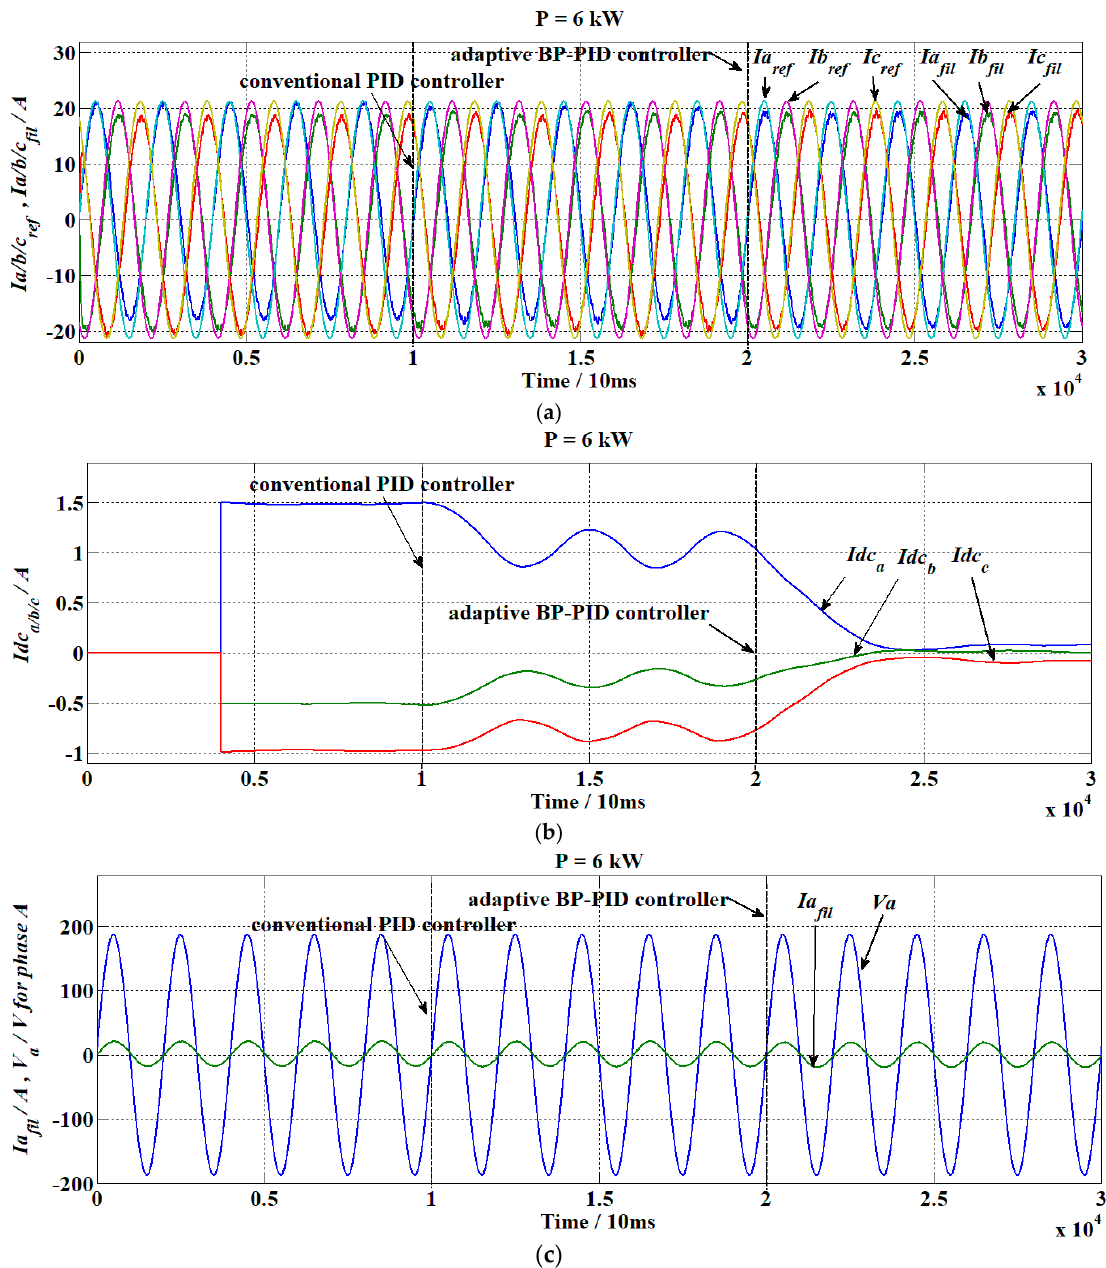
Figure 8. Waveforms of dc component, grid voltage and grid current using PID controller and adaptive BP-PID controller for dc-component suppression in three-phase system with ( P = 6.0 kW, Q = 0), respectively. ( a ) reference and feedback currents. ( b ) dc component of three-phase currents. ( c ) current and voltage output of phase-A.